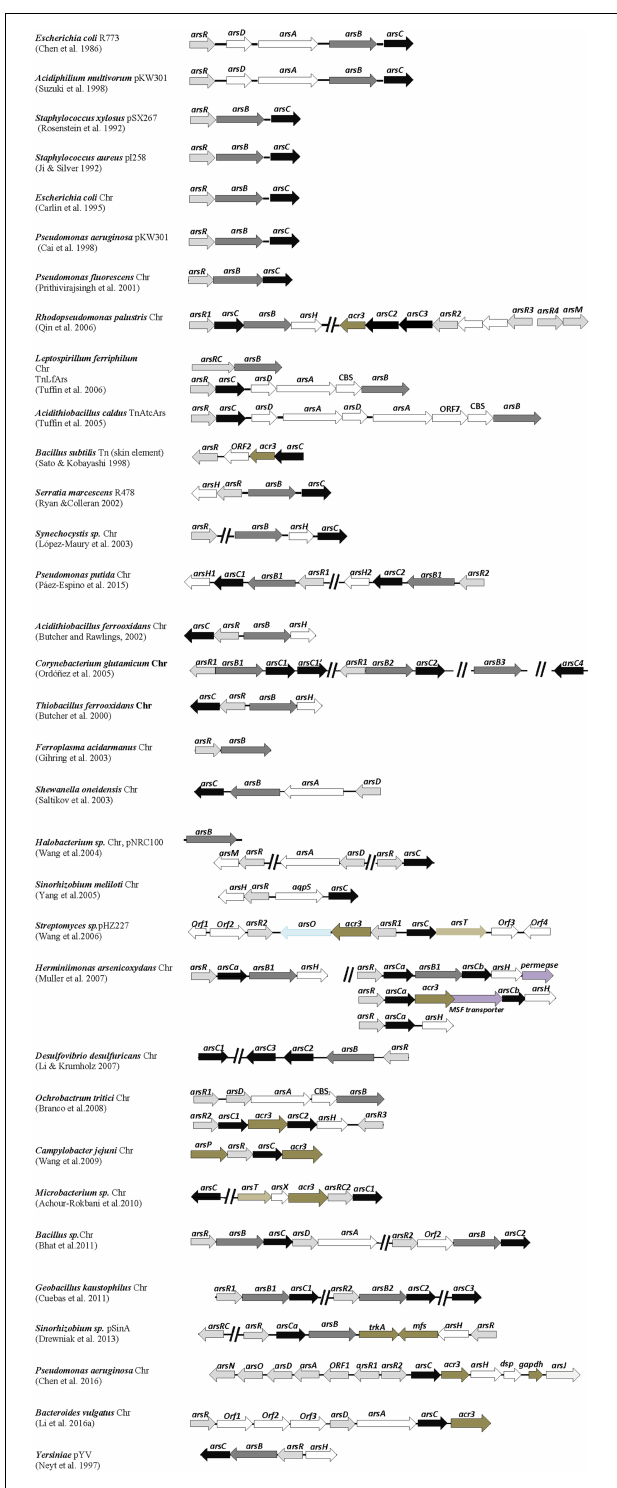
FIGURE 1 | Distribution of ars genes in arsenic-resistant prokaryotes. Genetic organization of ars operons from various arsenic resistant bacterial strains. Arrows represent open reading frames and orientation of transcription. Chr, chromosomal genes. Gene descriptions and references associated are given in the